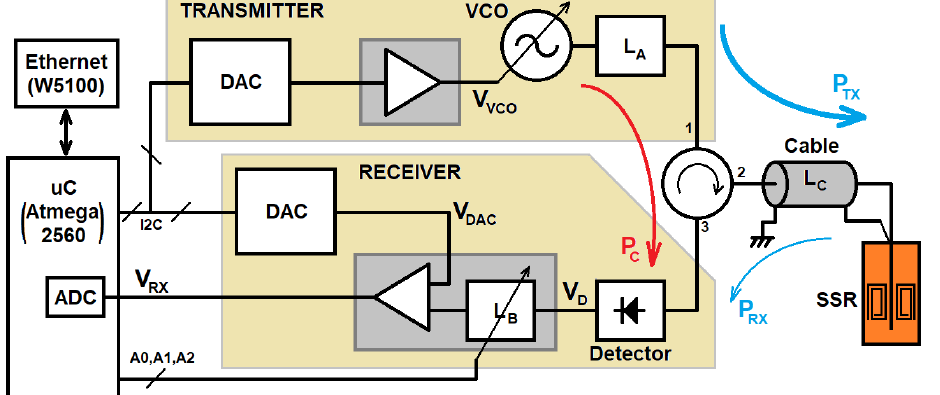
Figure 10. Sketch of the